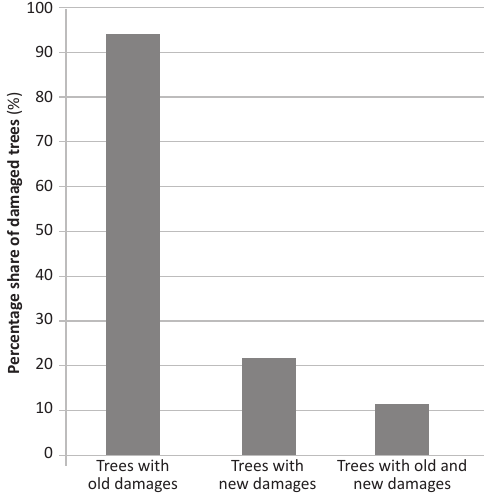
FIgURe 4. The distribution of damages depending on the type of